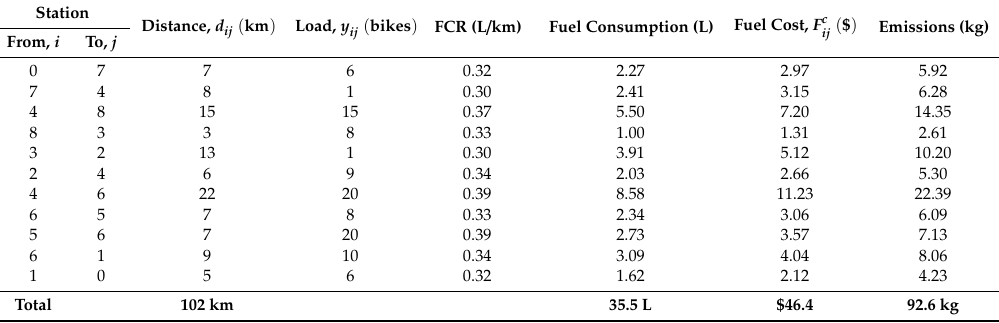
Table 7. The fuel consumption rate, fuel cost and the emission of the conventional vehicle for the rebalancing operation.